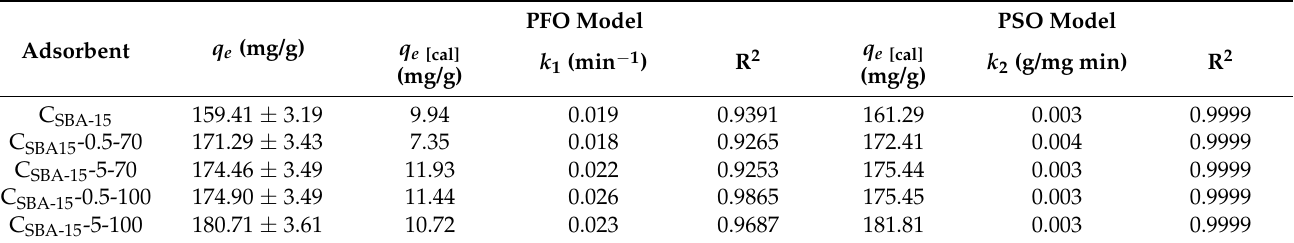
Table 3. Kinetic models